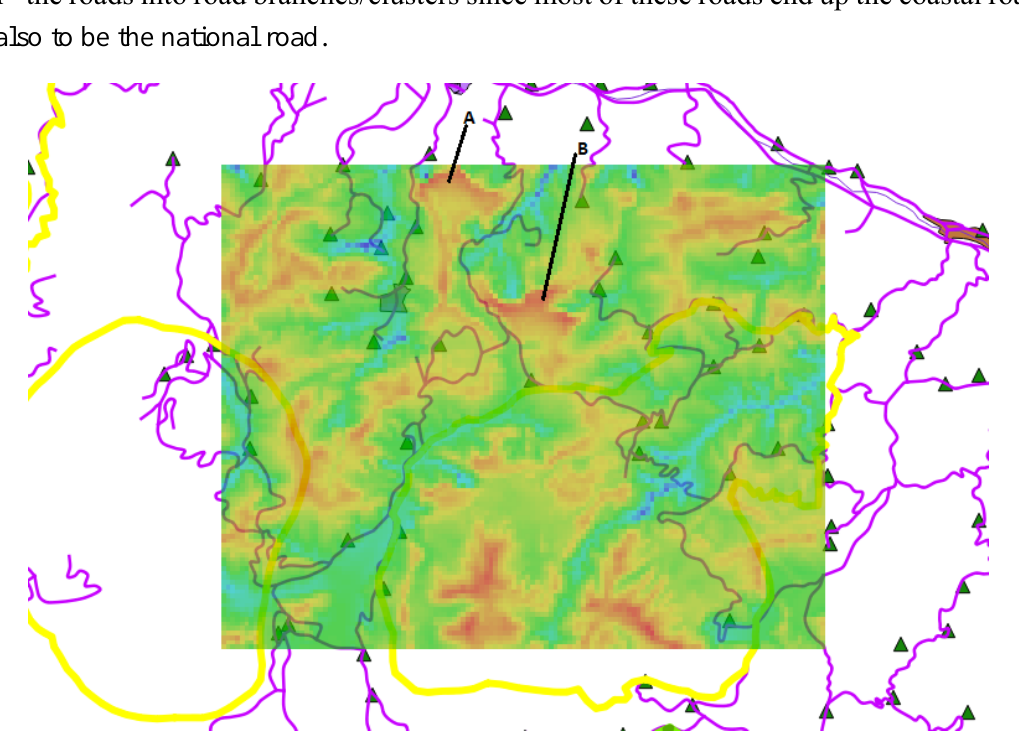
Figure 3. A comprehensive map of the area including constraints and geographical info.